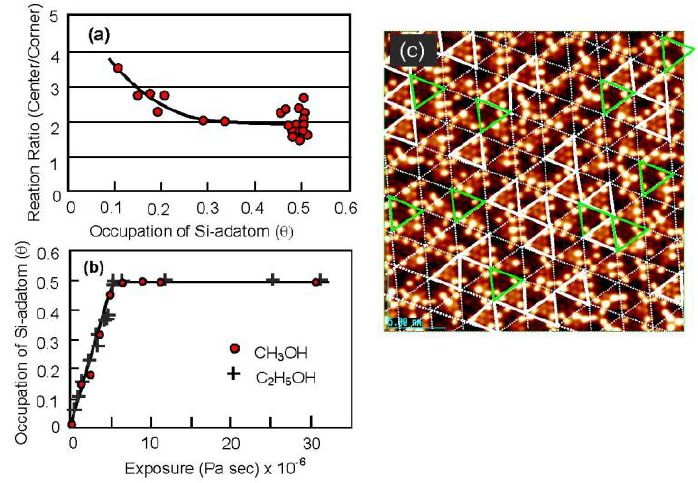
Figure 17. ( a ) Dissociation probability of CH OH on (corner Si-adatom/rest Si-atom) is 3 four time larger than that on (center Si-adatom/rest Si-atom) pair site; ( b ) Dissociation probability of CH OH and C H OH on the Si(111)-7 × 7 surface is coverage independent; 3 2 5 ( c ) Solid triangles are the half unit cells having three corner Si-adatoms